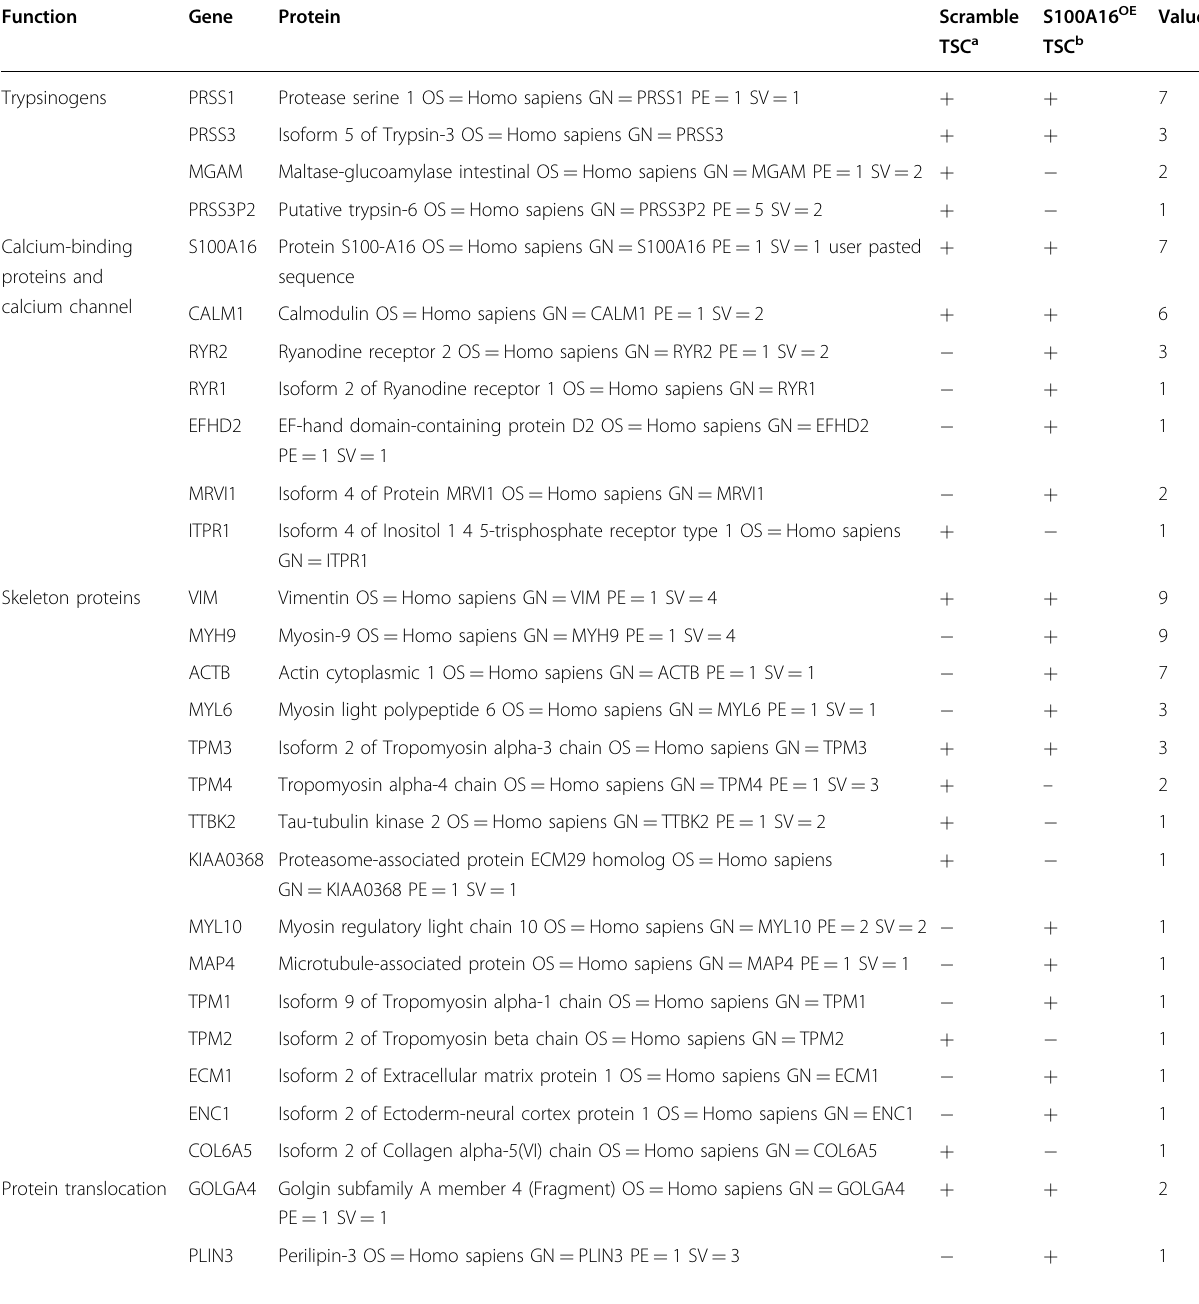
Table 1 Analysis of protein interaction about S100A16 in MS.